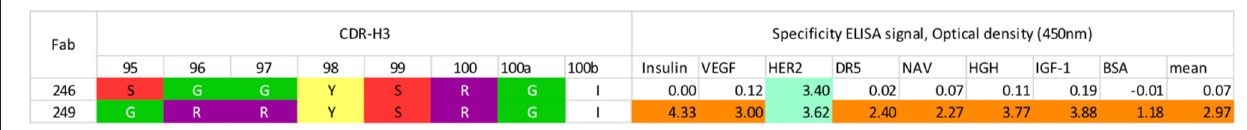
FIGURE 5 | CDR loop sequences (left) and affinities (right) of Fab 246 and Fab 249 CDR-H3 loop. The affinities of the two Fabs were tested against a set of eight antigens (Insulin, VEGF-Vascular Endothelial Growth Factor, HER2-Human Epidermal Growth Factor Receptor 2, DR5-Death Receptor 5, NAV-Neutravidin, HGH-Human Growth Hormone, IGF-1-Insulinlike Growth Factor 1, BSA-Bovine Serum Albumin) (31). The numbering of the CDR residues is according to the nomenclature of Kabat et al.